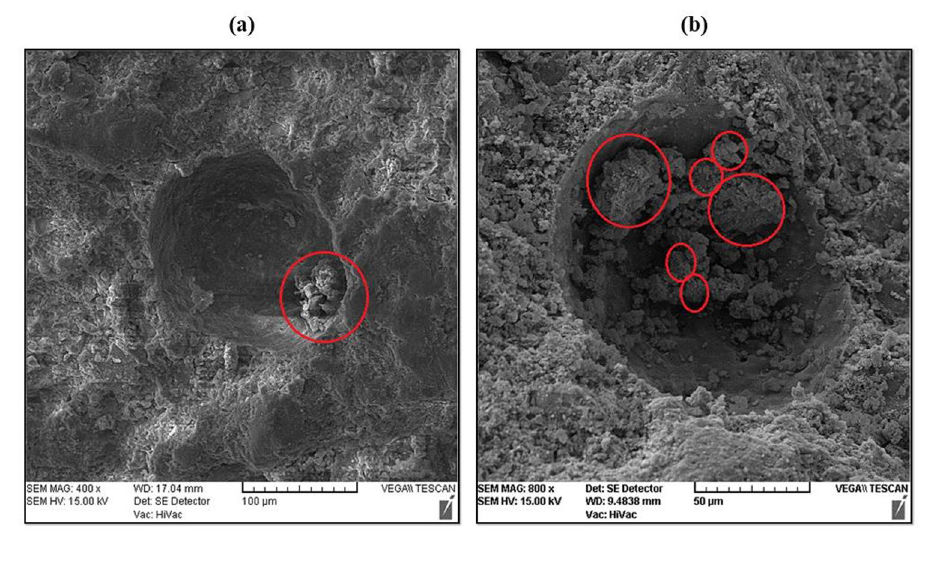
Fig. 13 SEM micrographs [49]: a : control specimen; b : UHPC with 4% of nano-silica; c : UHPC with 5% of